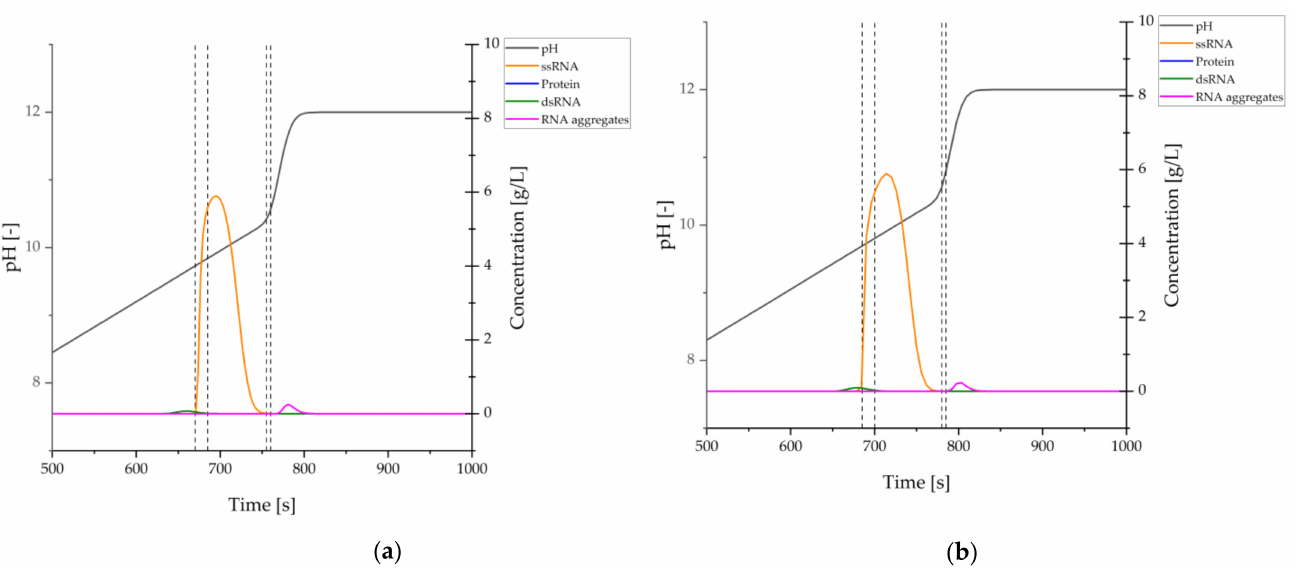
Figure 9. MCSGP chromatograms of the monolithic MMC separation; ( a ) is the chromatogram of cycle 1 and ( b ) is the chromatogram of cycle